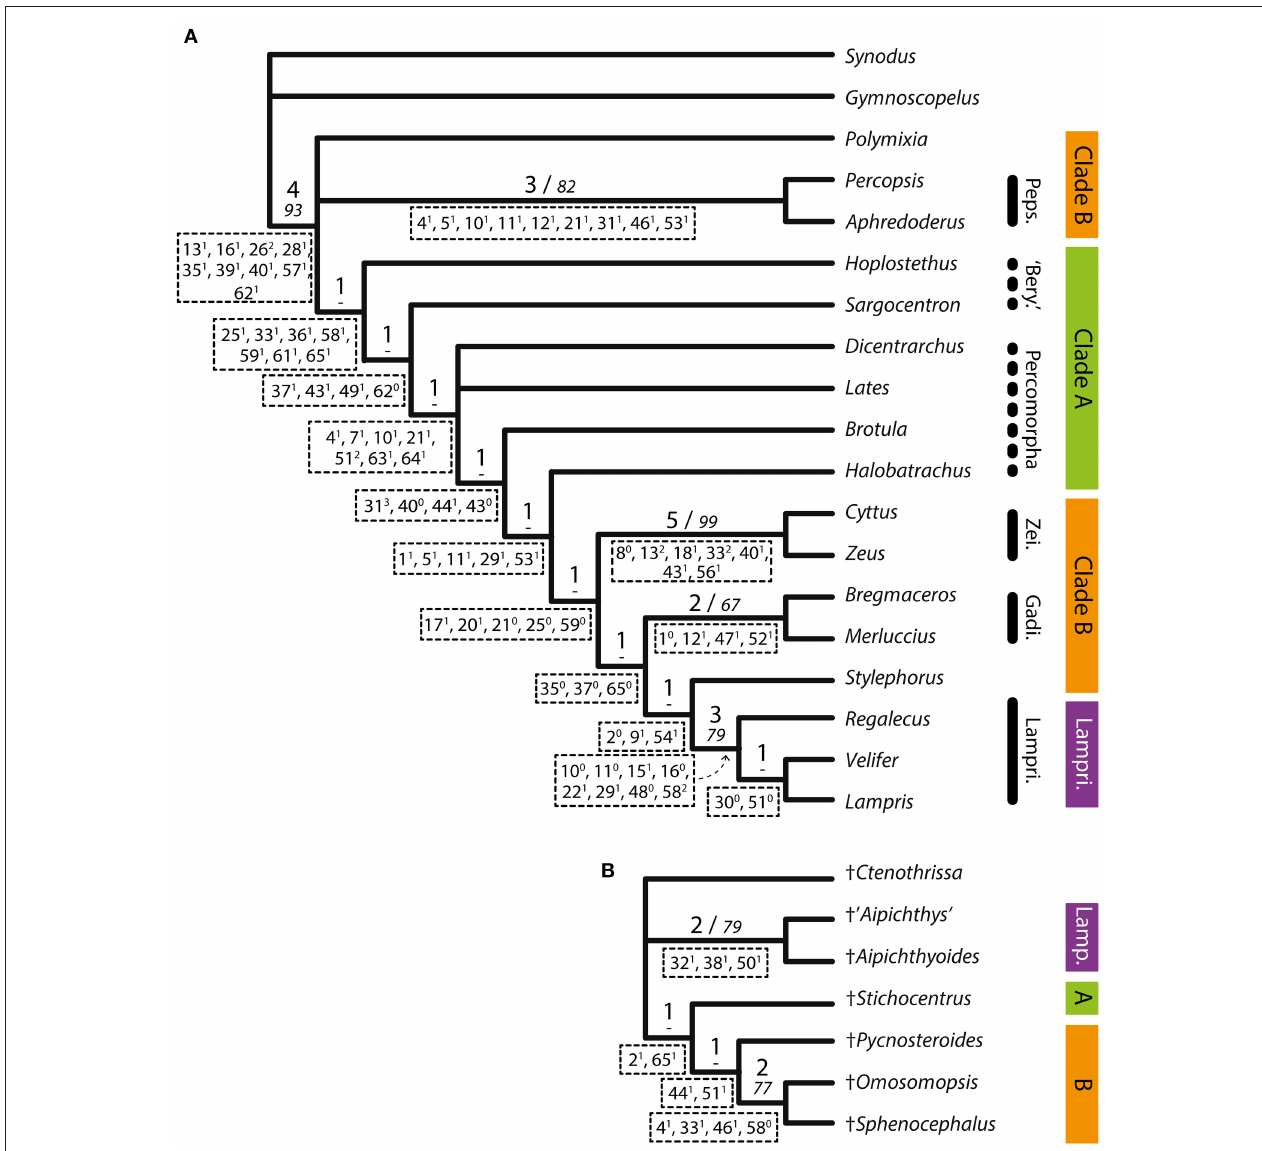
FIGURE 5 | (A) Strict consensus of the four parsimonious trees obtained from Analysis 2 (extant taxa only). Length = 166, CI = 0.482, RI = 0.676. (B) Tree obtained from Analysis 3 (fossil taxa only). Length = 43, CI = 0.791, RI = 0.609. The clade names on the right refer to the results of Analysis 1 ( Figure 4 ). Support values are above branches: Bremer indexes (bigger font)/bootstrap values (italics). Unambiguous synapomorphies are below